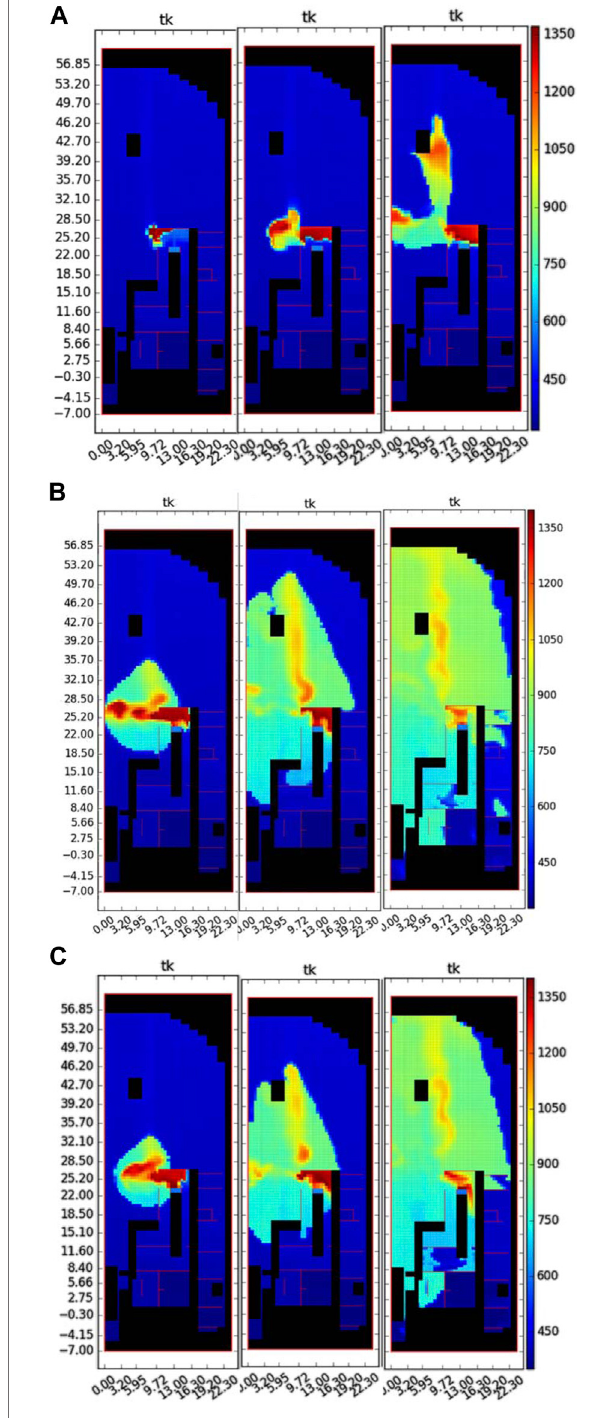
FIGURE11| R-Zview ofthetemperature at the PZR compartmentslide (0.5 s – 1 s – 2 s after ignition). (A) TFC model. (B) S turb (cid:1) 800 m / s . (C) S turb (cid:1) 600 m / s .